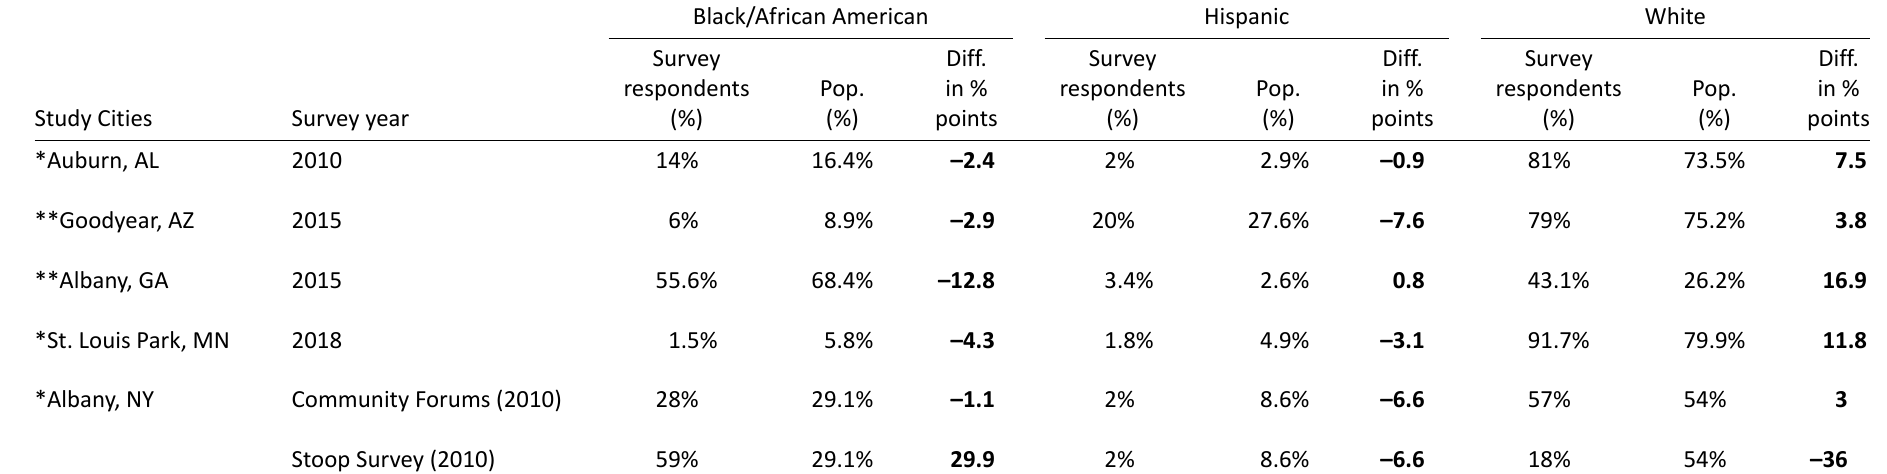
Table 4. Race/ethnicity distribution of population (during survey years) vs. survey respondents. Black/African American Hispanic White Diff.